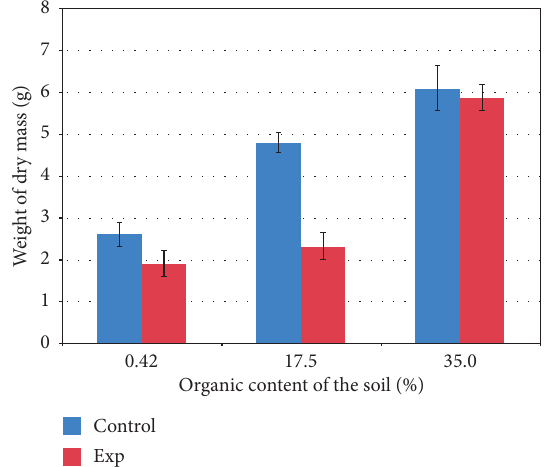
Figure 2: Weight of dry shoots of P. oleracea at different levels of organic matter in soil in both control and experimental samples (mean of five replicates ± SE, 95%